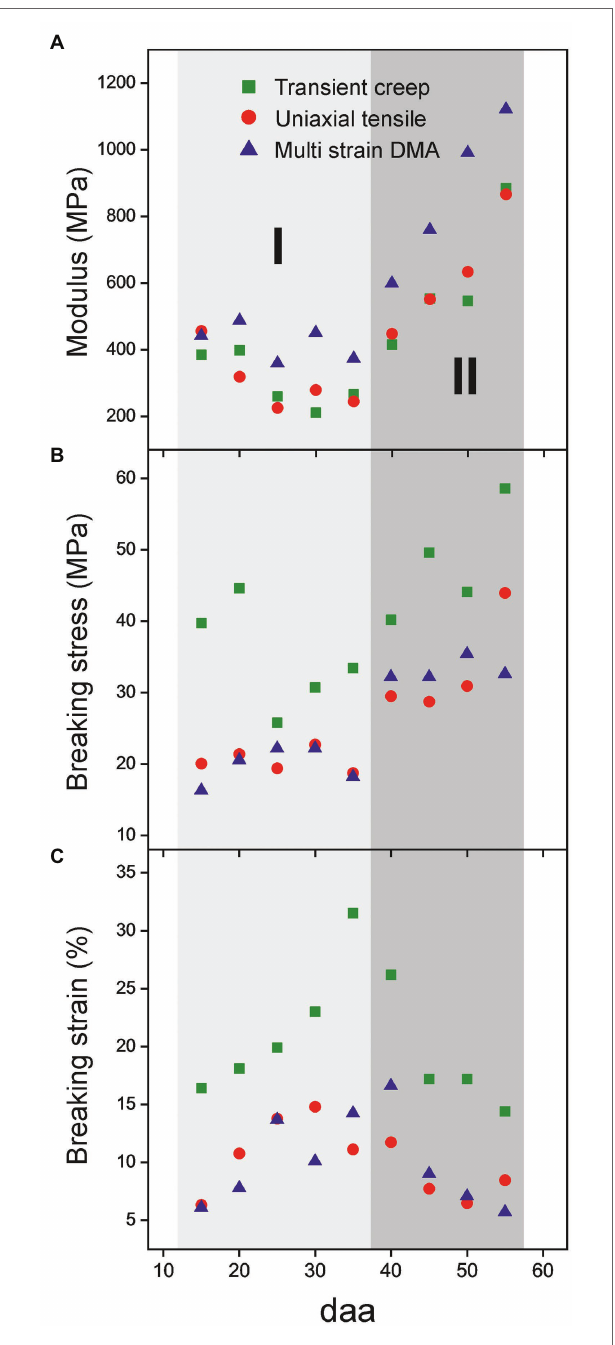
FIGURE 4 | Evolution of mechanical parameters of isolated cuticles along tomato fruit development. (A) Modulus, (B) breaking stress and (C) breaking strain. Two stages (I, 15-35 daa and II, 40-55 daa) can be